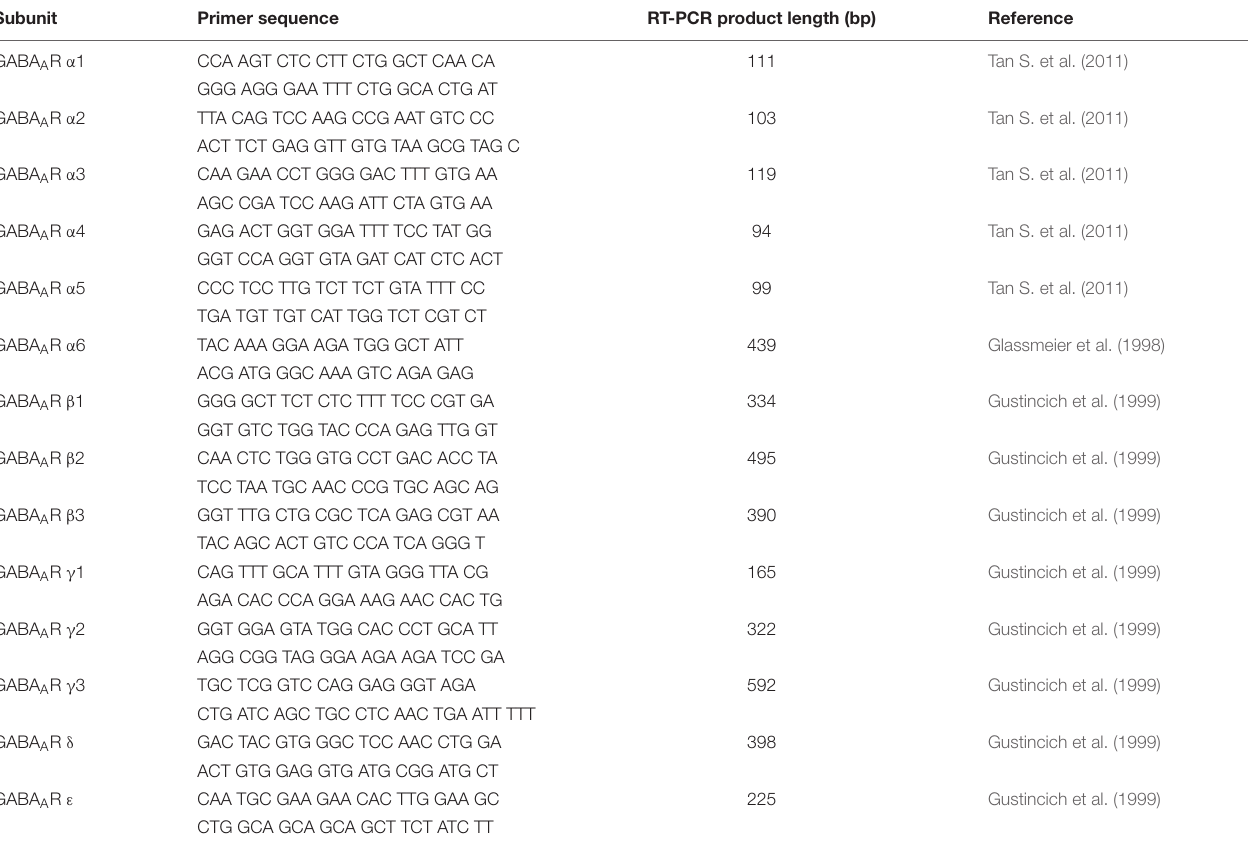
TABLE 1 | Details of RT-PCR primer sequences used in the study. Subunit Primer sequence RT-PCR product length (bp)